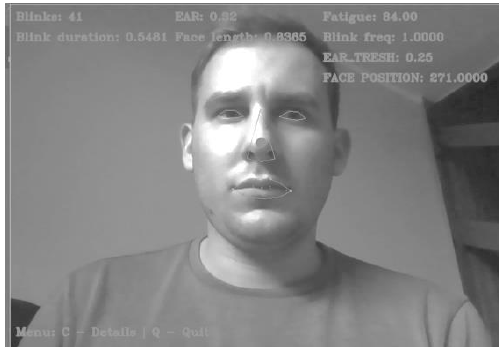
Fig. 6. User’s interface when the driver is alert